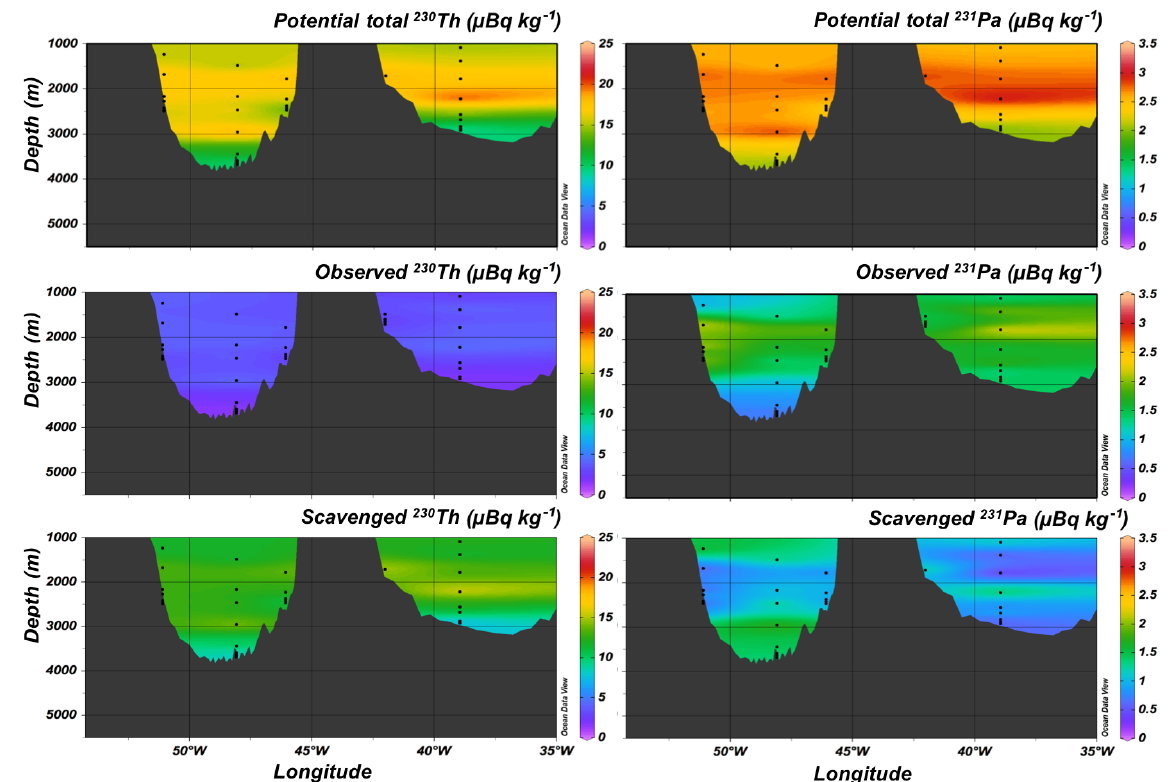
Figure 7. Potential total, observed, and scavenged components of 230 Th and 231 Pa in waters > 1000m water depth and west of 35 ◦ W.